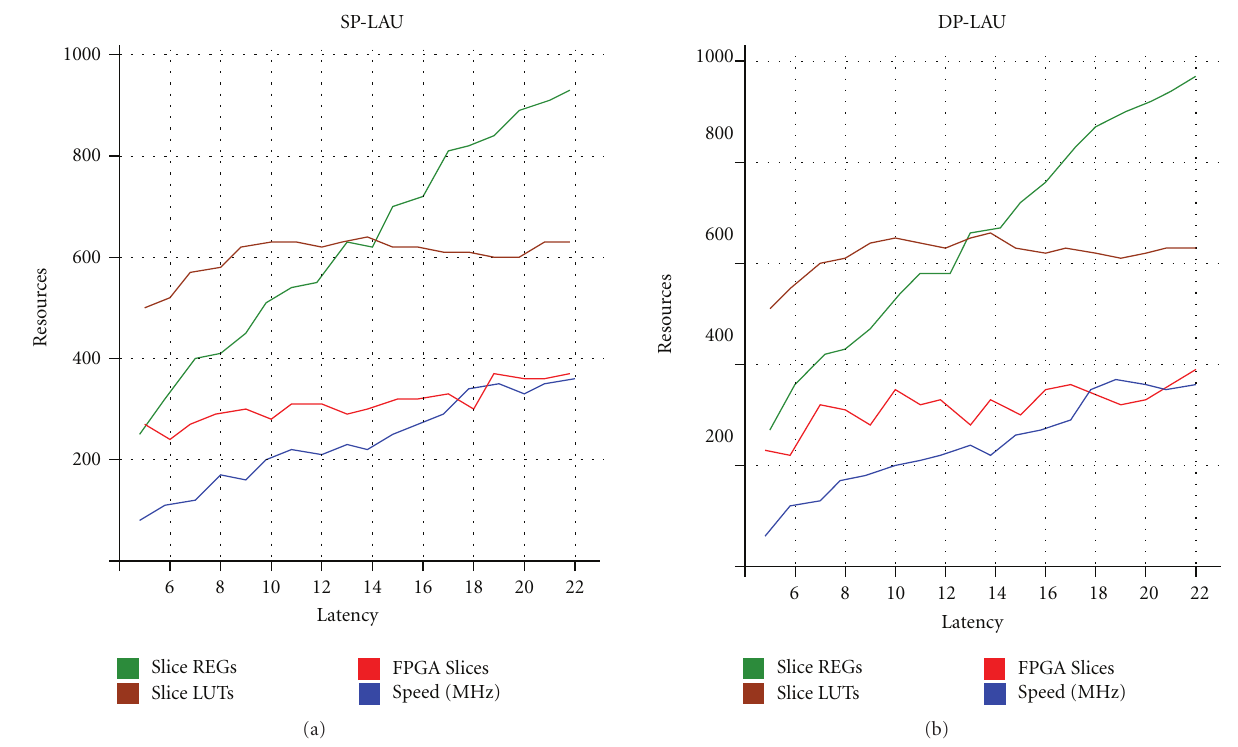
Figure 5: Resources and performance of alternative SP and DP LAU implementations.